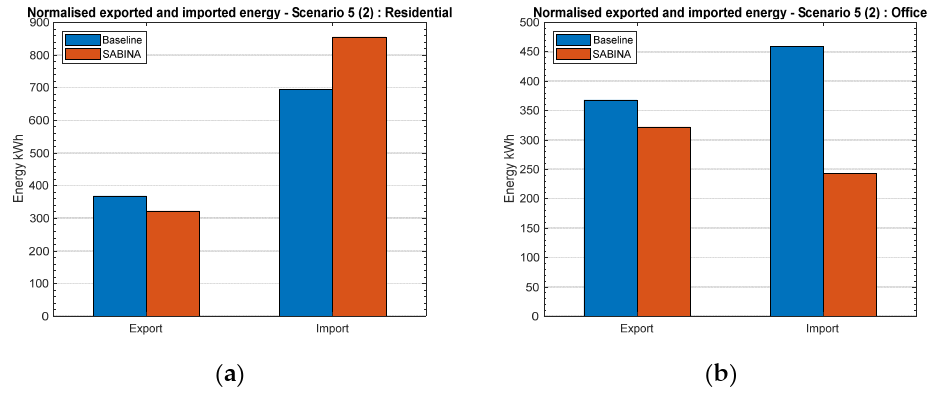
Figure 8. Normalised energy grid exchange: ( a ) residential (2); ( b ) office (2).